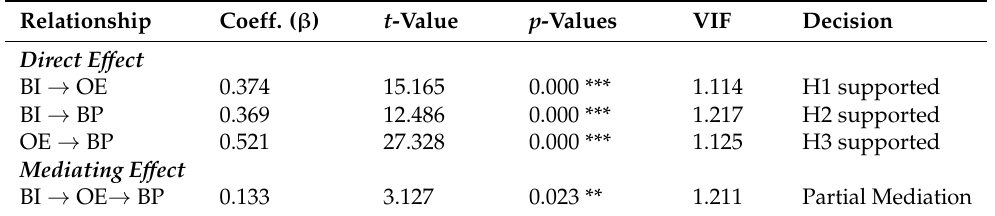
Table 6. Analysis of